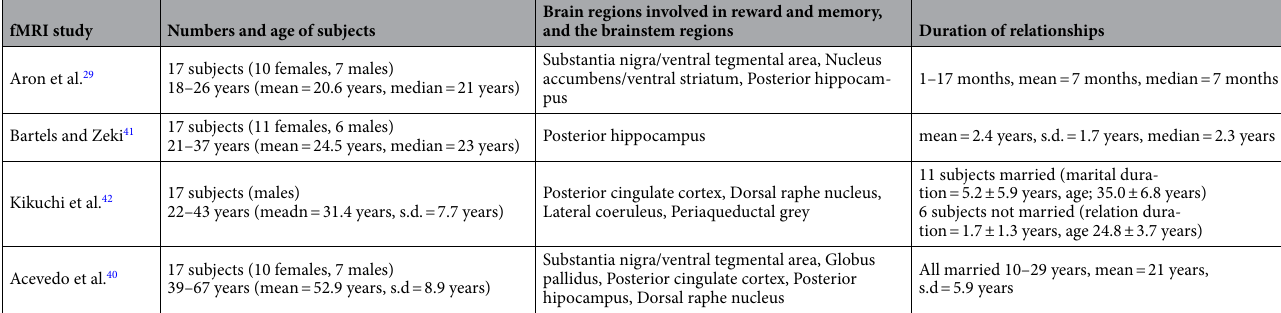
Table 1. Summary of the previous fMRI studies of human attachment